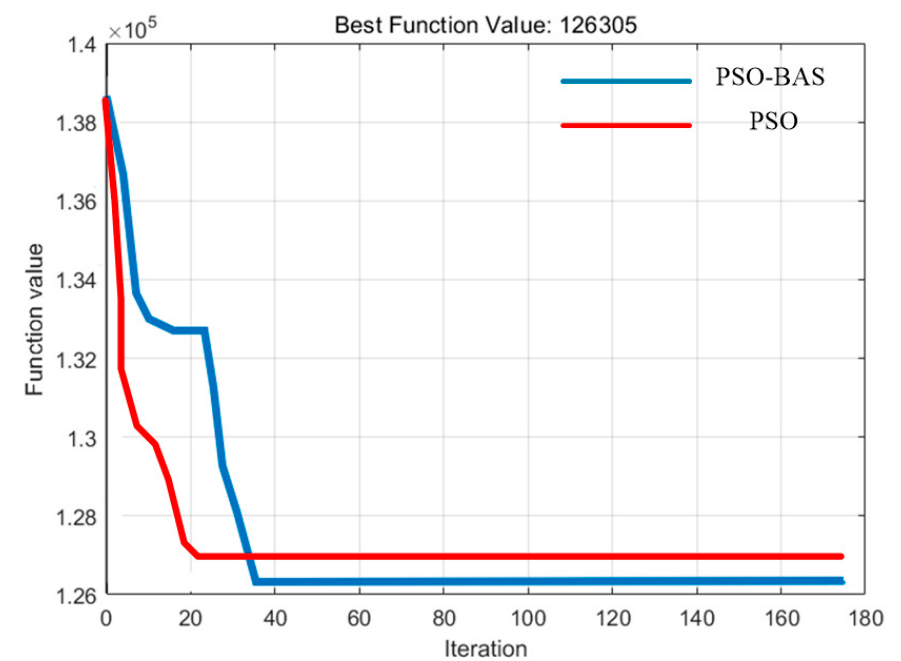
Figure 9. The 2D EW cost with the number of iterations.